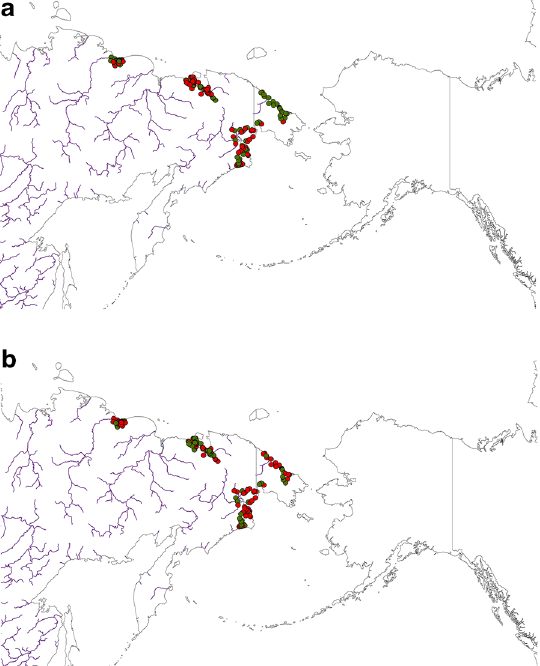
Figure 4. Best-available compiled raw data of Greater White-fronted Goose ( Anser albifrons) presence/absence for ( a ) Brood, and ( b ) Non-breeders in the study area. For both figures presence is shown in red and absence in green. Map created by FH with OpenSource QGIS and ArcGIS Desktop 10.6 academic